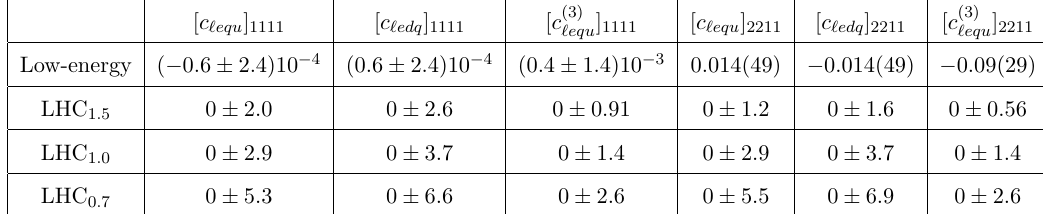
Low-energy ( (cid:0) 0 : 6 (cid:6) 2 : 4)10 (cid:0) 4